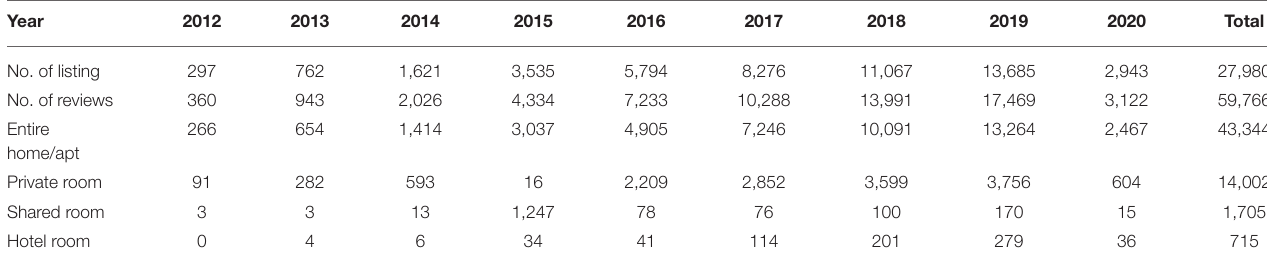
TABLE 2 | Descriptive statistics of review